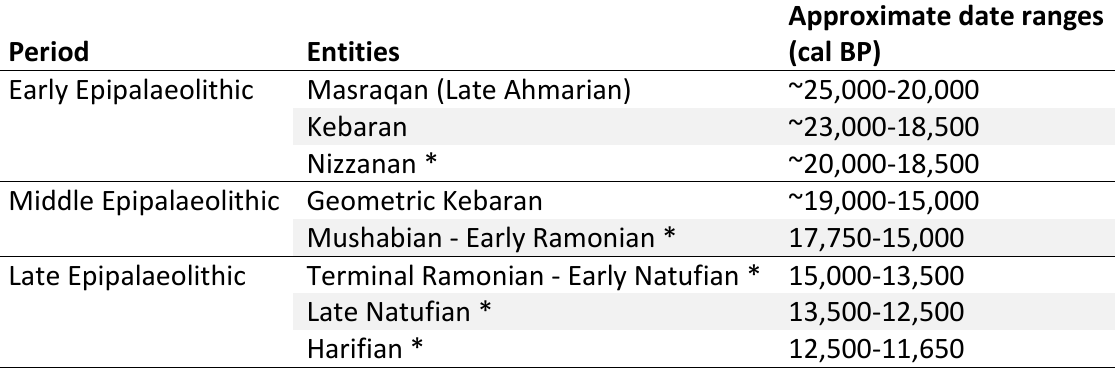
Table 1. Entities and approximate date ranges for the Epipalaeolithic of the Negev (Dates after Goring-Morris 2017). Abbreviations: * Entities with habitual use of the microburin